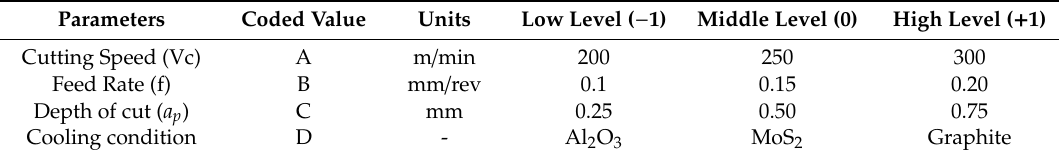
Table 5. Machining parameters and their